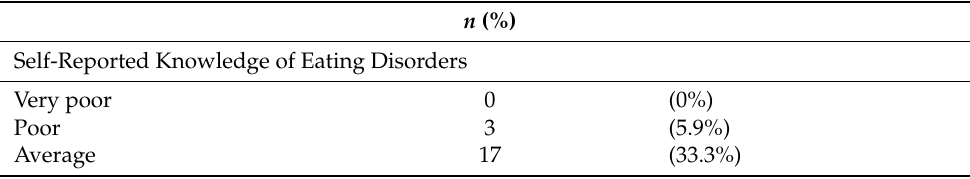
Table 2. Participant perceptions regarding eating disorder prevention in schools presented as fre- quency (%) ( n =